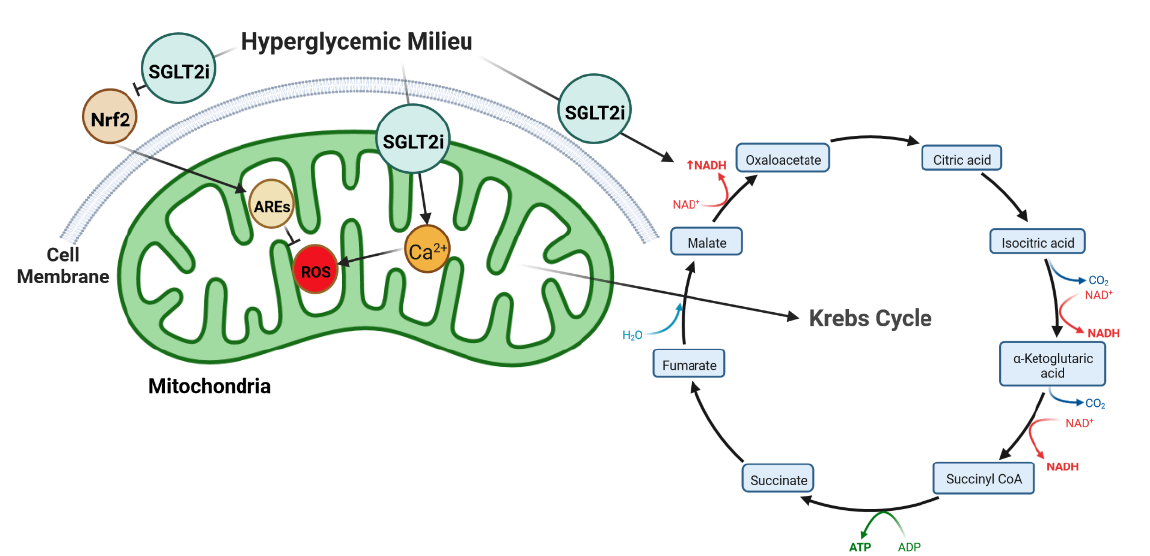
Figure 2: SGLT2 inhibitors reduce mitochondrial ROS production by at least 3 pathways as 1. Damping the inhibitory effects of hyperglycemia on Nrf2 signaling, 2. Reduction in NADH level produced by Krebs cycle (as substrate of ROS generation), and 3. Reduction in mitochondrial Ca 2+ overload (which initiates ROS